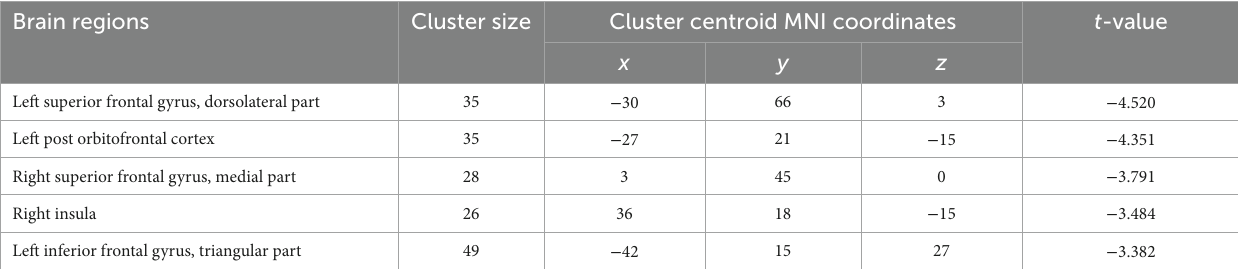
TABLE 2 Brain region information of ALFF comparison between patients with MCI and HC groups. Brain regions Cluster size Cluster centroid MNI coordinates t